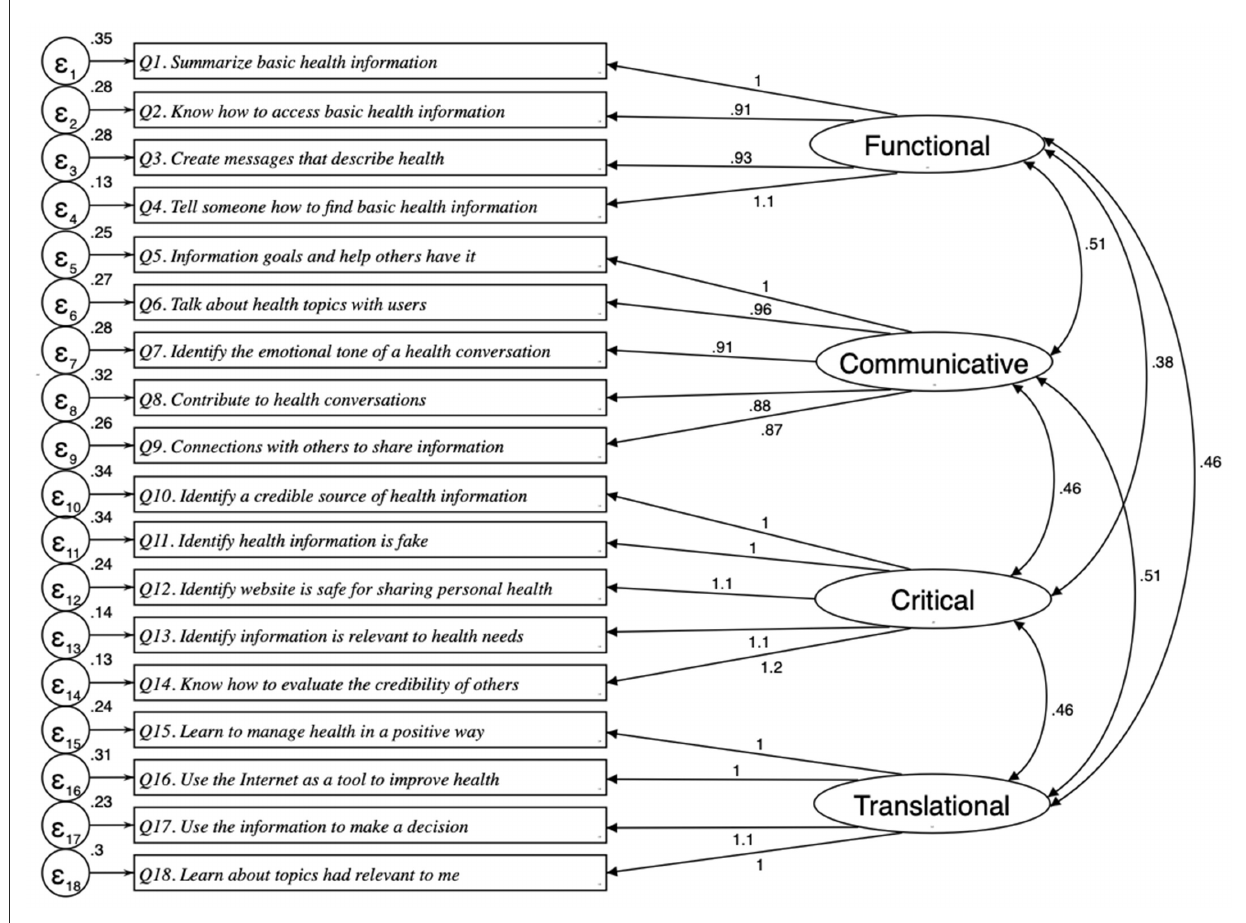
FIGURE1 CFA models through structural equation modeling for the transactional eHealth literacy instrument (RMSEA = 0.116; CFI: 0.907; SRMR: 0.047).